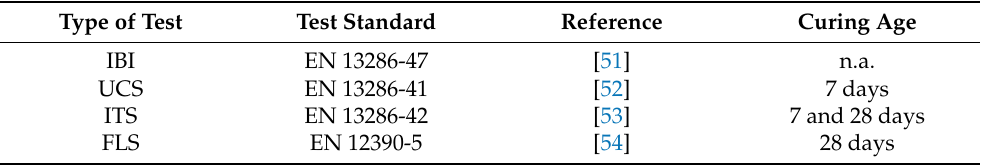
Table 5. Type of test and curing age adopted in the experimental program.